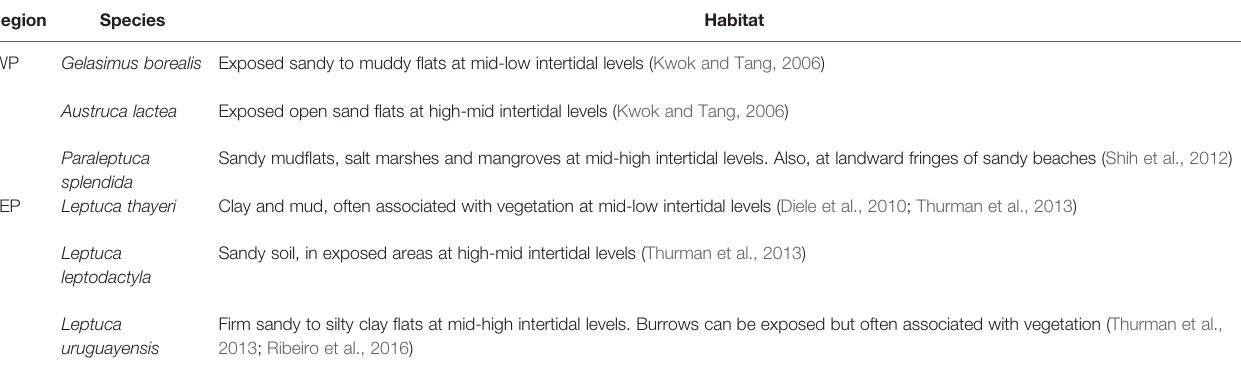
TABLE 1 | Summary of the habitat characteristics where the model species occur. Region Species